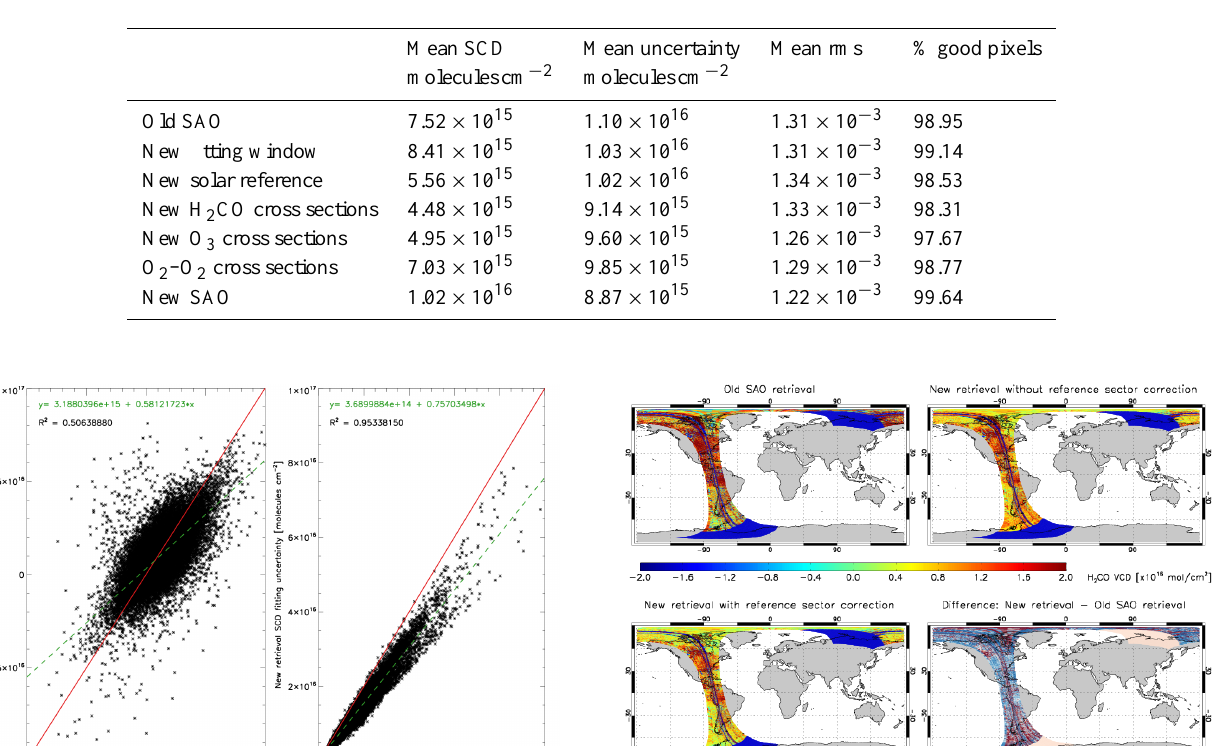
Table 3. Spectral fitting results for Orbit 11118. Results from the old SAO retrieval and from different new retrieval settings are included to illustrate the change induced by each one of them.